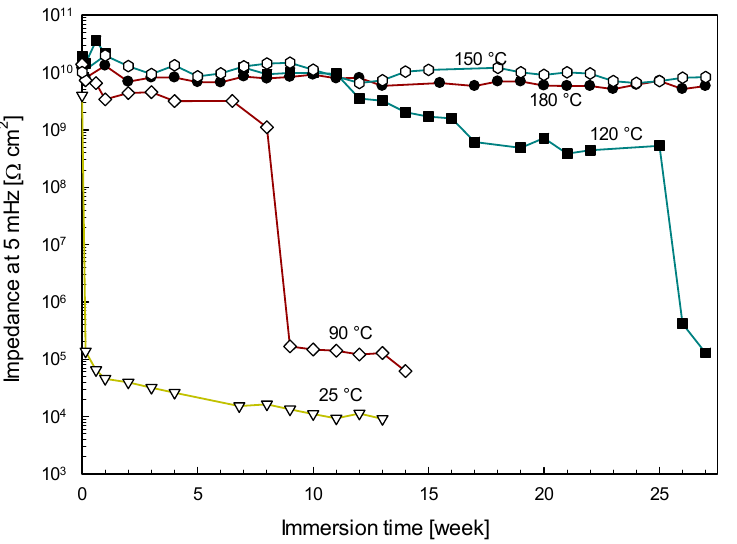
Figure 6. Time dependence of the impedance value |Z| 5 mHz recorded in 3.5 wt.% NaCl for PBMA- siloxane coatings deposited on structural steel and cured at different curing temperatures. The withdrawal rate was 2.3 mm/s.